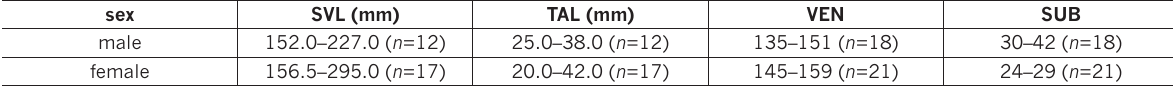
Figure 2. Oligodon sublineatus male, NMSL 5161 collected from Nuwara Eliya (1600 m a.s.l.), Sri Lanka: A dorsal aspect of head B ventral aspect of head C lateral aspect of head D lateral aspect of midbody E dorso-lateral aspect of right hemipenis (scale = 1 Table 2. Some sexual dimorphic characters of Oligodon sublineatus based on examined material. See Methods for abbreviations.